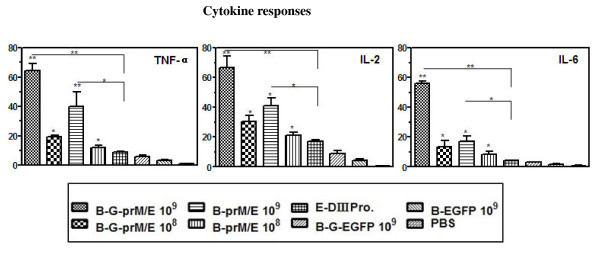
Analysis of inflammatory cytokine production following immunization with baculoviruses. Real-time PCR was conducted for three cytokines, TNF-α, IL-2 and IL-6. Total RNA was obtained as described in Figure 4. The graphs obtained for the expression of TNF-α gene, IL-2 gene and IL-6 gene, respectively. Data are presented as means ± SD (n = 3). *, p<0.05; **, p<0.01 compared to the value for 109 PFU of Bac-G-EGFP (control virus)-immunized group.